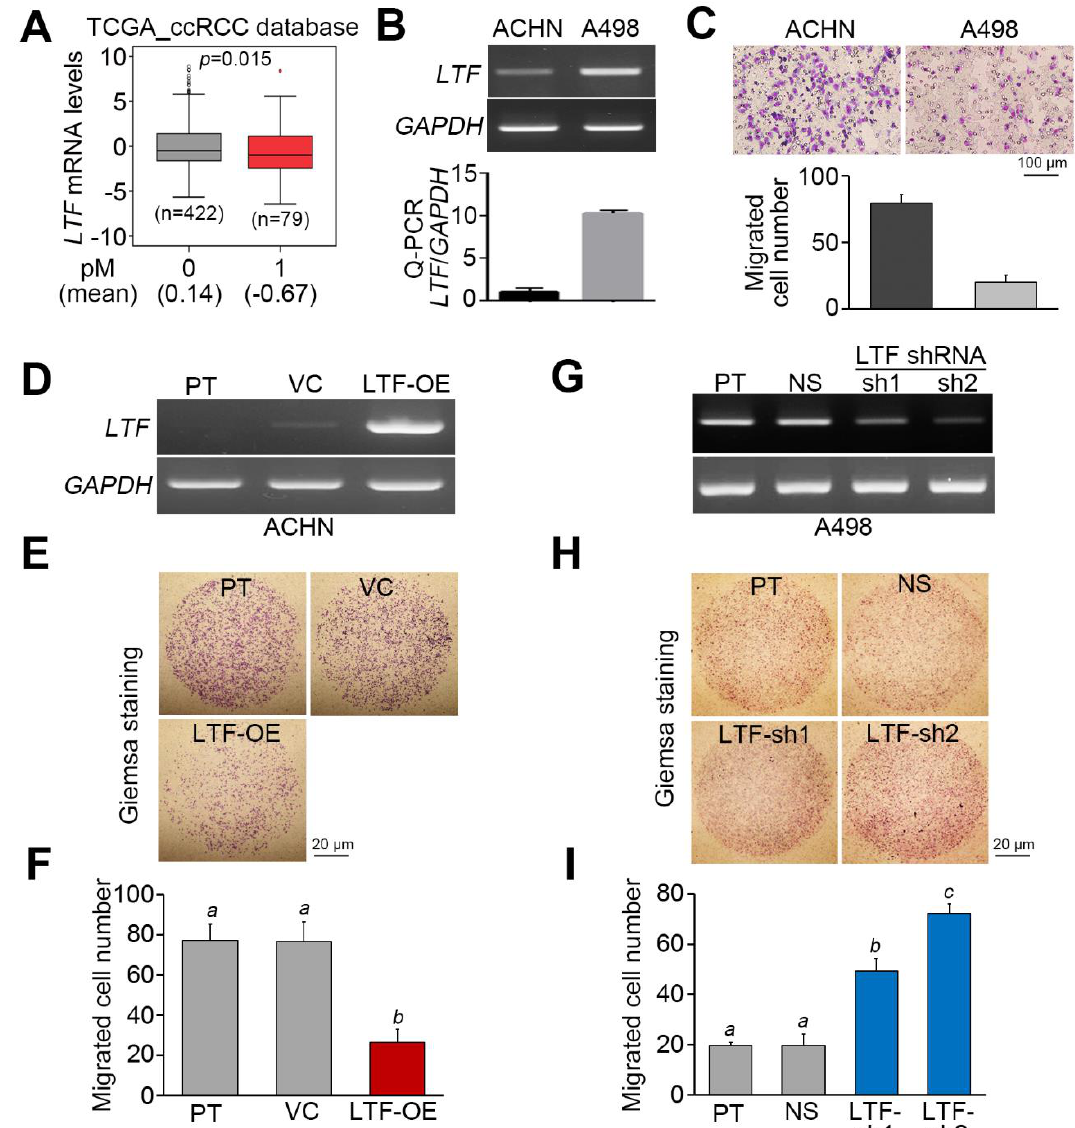
Figure 3. LTF expression negatively associates with cellular migration ability in ccRCC. ( A ) Boxplot for the transcriptional profile of LTF gene expression in primary tumors derived from TCGA ccRCC patients without (0) or with (1) pathologic M (pM) status. Student’s t-test was used to estimate the statistical significance. ( B ) LTF mRNA levels determined by RT-PCR (upper) and quantitative PCR (bottom) in the tested ccRCC cell lines, ACHN and A498. ( C ) Giemsa staining (top) and data from three independent experiments (bottom) analyzing migrated cells in the 3-h Transwell assay of ccRCC cells. ( D – F ) LTF mRNA levels determined by RT-PCR ( D ) and Giemsa staining and ( E ) a histogram representing data from three independent experiments ( F ) analyzing migrated cells after a 2-h Transwell assay in ACHN cells without (parental, PT) or with vector control (VC) or LTF overexpression (OE). ( G – I ) LTF mRNA levels determined by RT-PCR ( G ) and Giemsa staining and a ( H ) histogram representing data from three independent experiments ( I ) analyzing migrated cells after 4-h Transwell assay in A498 cells without (parental, PT) or with a stable transfection for nonsilencing (NS) control shRNA or two independent LTF shRNA (sh) clones. In ( B , D , G ), GAPDH was used as an internal control for RT-PCR experiments. The di ff erent letters in each column of ( F , I ) indicate statistical significance at p < 0.05 as determined by one-way ANOVA with Tukey’s test.